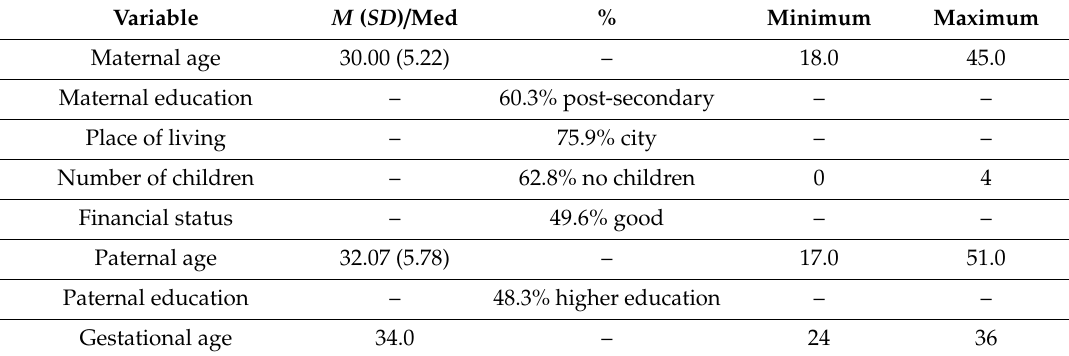
Table 1. Socio-demographic variables of the study